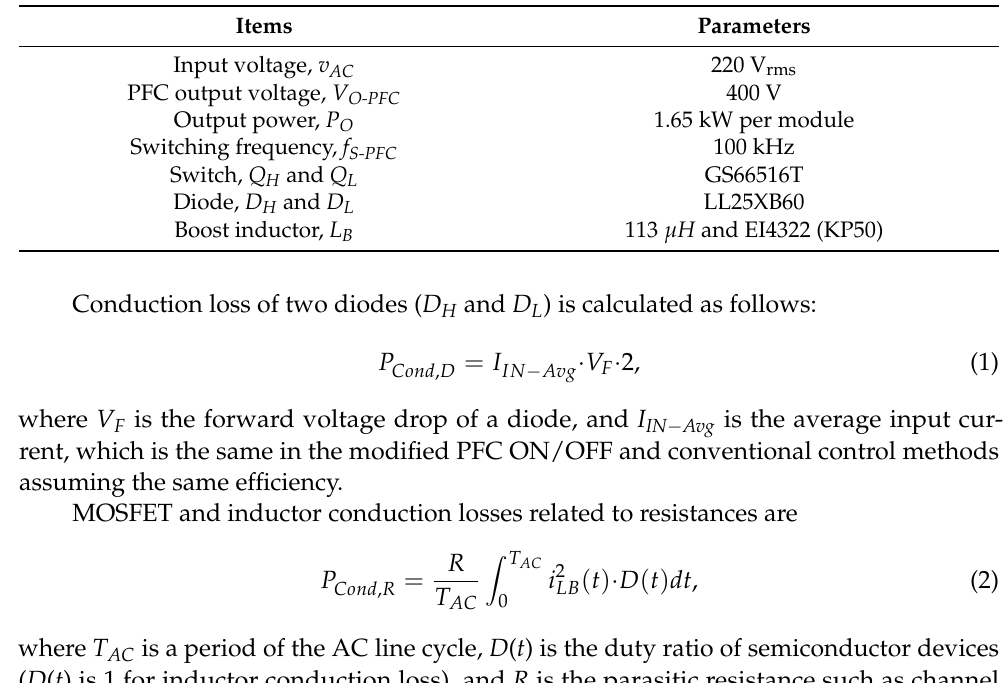
Figure 3. Loss breakdown of the interleaved totem-pole bridgeless converter with the conventional interleaving control. Table 1. Designed parameters of 3.3 kW interleaved totem-pole bridgeless boost PFC converter.